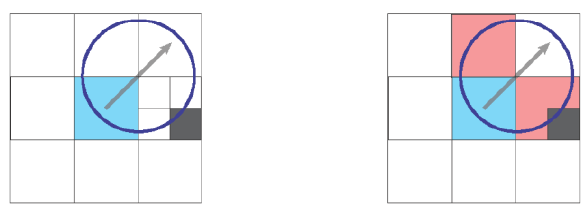
Figure 10: Collision avoidance: The area that must be checked for occupied nodes